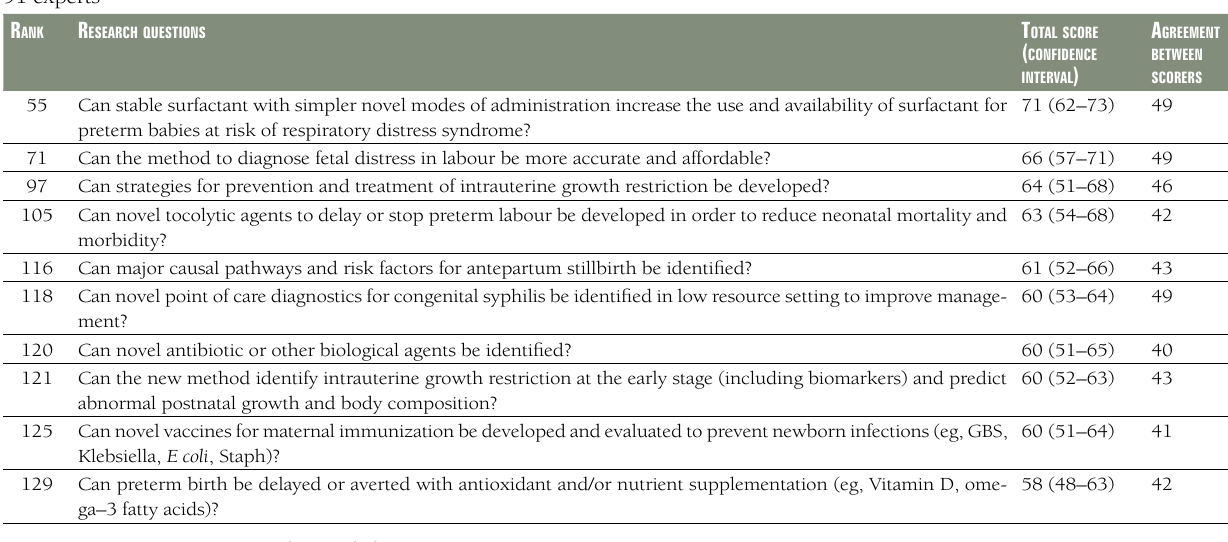
Table 3. Top ten discovery research priorities in discovery for improving newborn health and birth outcomes by 2025 as ranked by